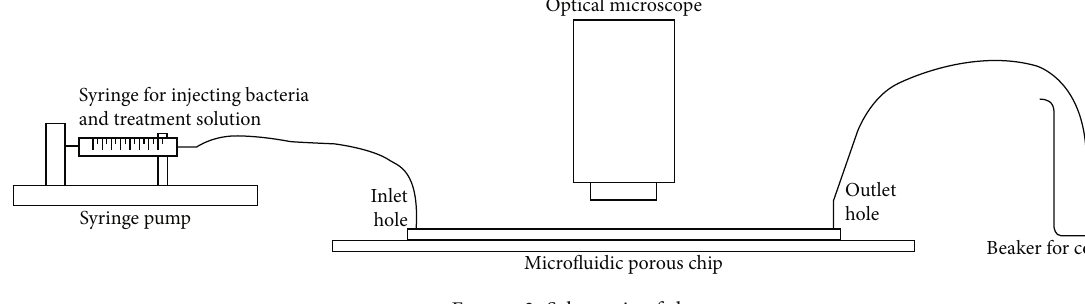
Figure 3: Schematic of the test set-up. Table 1: Testing